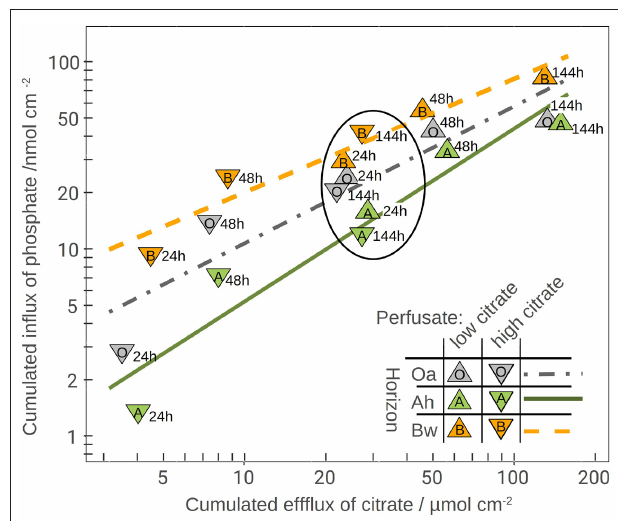
FIGURE 4 | Phosphate influx over citrate efflux together with the logarithmic model fitting (model parameters in Table 4 ). The numbers right of the symbols are the time in hours. The ellipse highlights the overlapping results of both perfusate-citrate concentrations where the values of the low citrate treatment cover 144 h efflux and those of the high-citrate treatment only 24h.